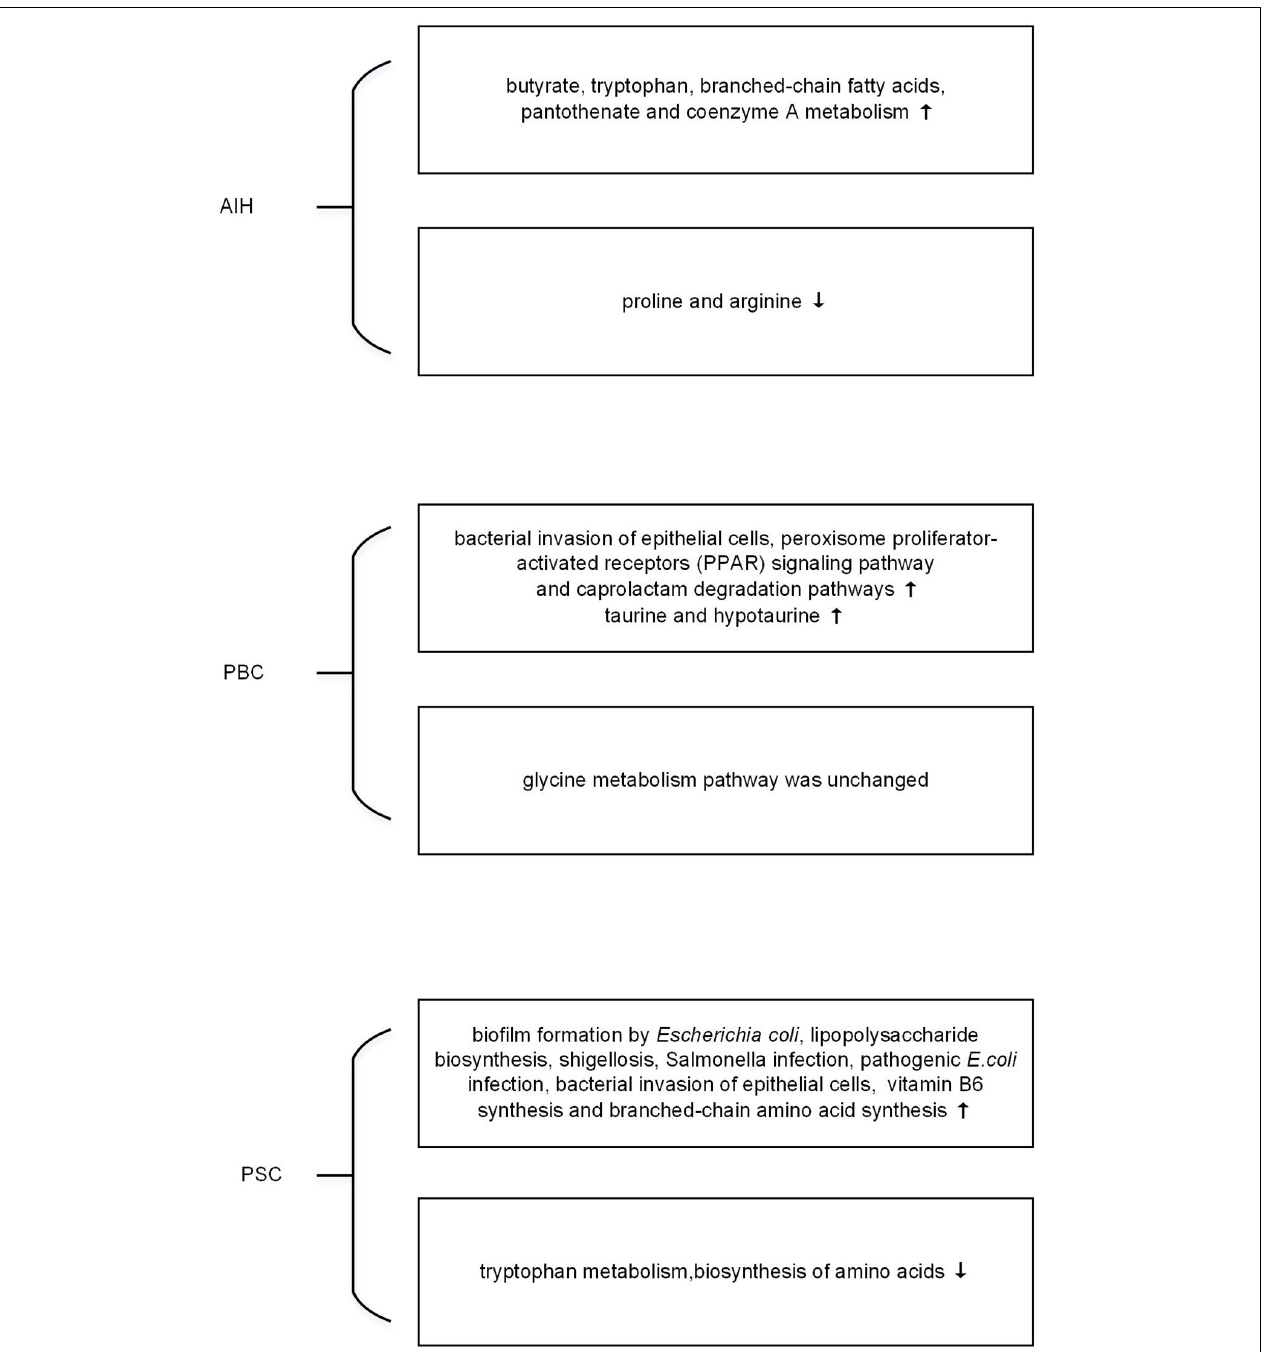
FIGURE 1 | The changes of microbial function predicted by metagenomic in autoimmune liver diseases (AILDs).